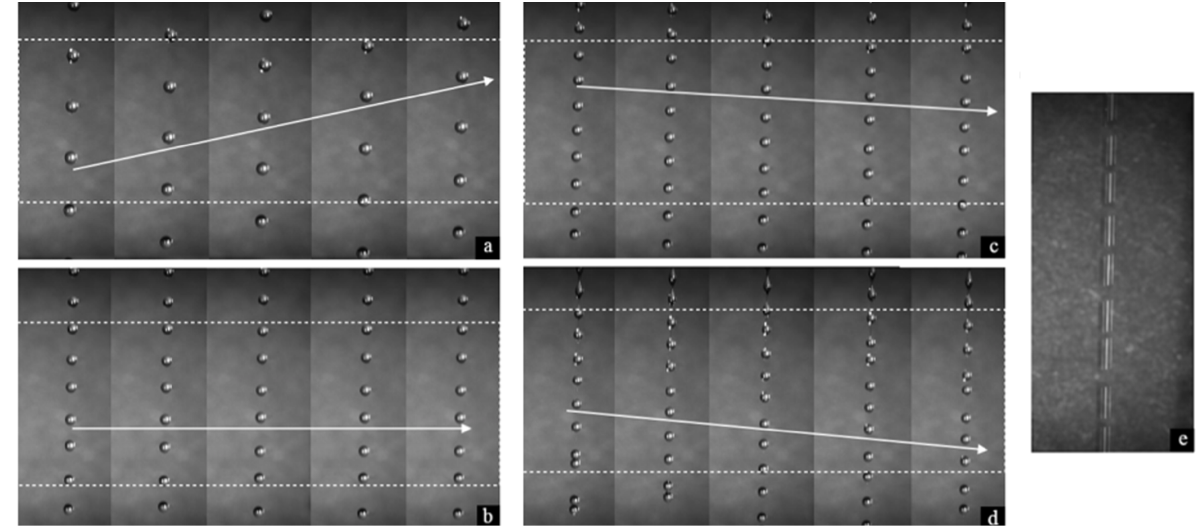
Figure 3. Observation of the droplet production by varying the vibration frequency (alginate solution 18 g/L, nozzle 800 µm, flow rate 38.5 mL/min) with recording duration of 0.2 ms. In this figure: ( a ) 300 Hz, ( b ) 500 Hz, ( c ) 600 Hz, ( d ) 700 Hz, ( e ) simulation of recording with 0.7 ms duration.